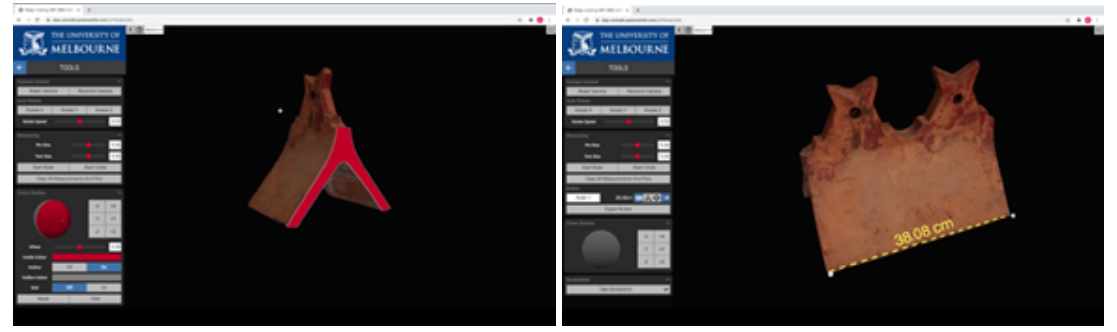
Figure 7. Photogrammetric object displayed in 3D viewer (Pedestal) which can allow users to interrogate. Left: screenshot of measuring tool applied to a photogrammetric object in 3D viewer (Pedestal); right: screenshot of sectioning tool applied to a photogrammetric object in 3D viewer (Pedestal) (Source: